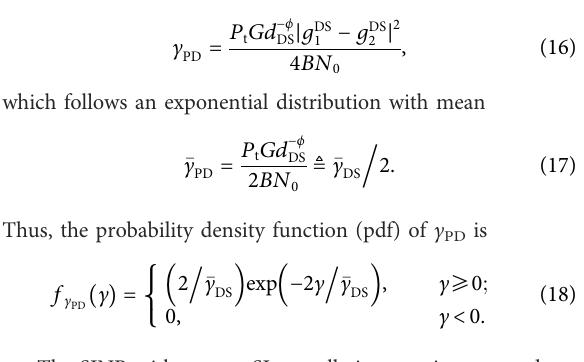
FIGURE 5 Alice ’ s and Bob ’ s timing sequences of antenna switching, in the presence of timing